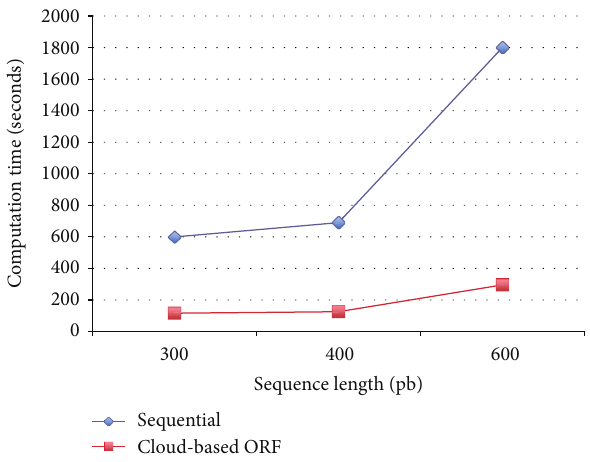
Figure 9: Comparisons of the computation time between sequential and cloud-based ORF phylogenetic